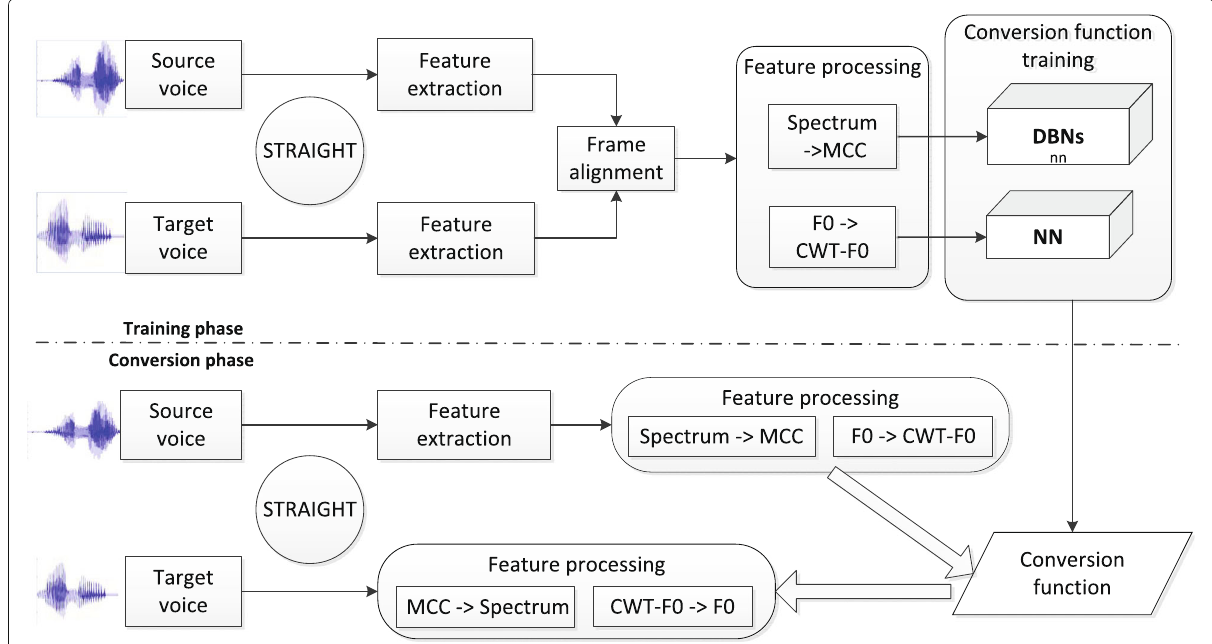
Fig. 6 Framework of the proposed